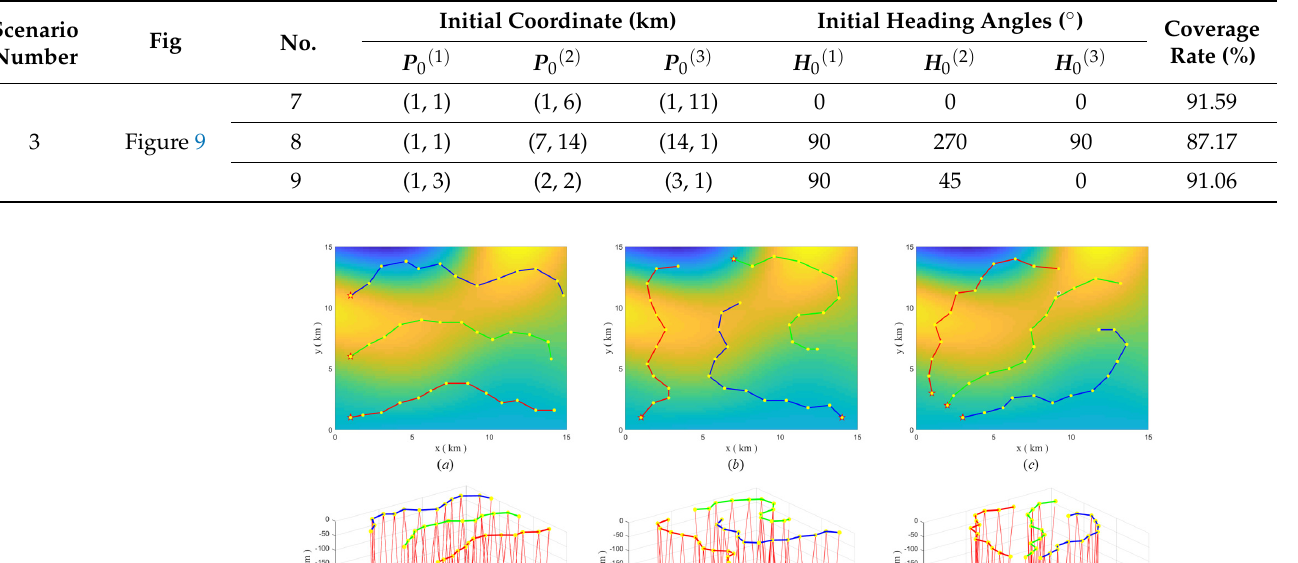
Figure 9. The MGCPP − ACO algorithm path planning results in scenario 3 (where ( a – c ) are 2D plane trajectories, and ( d – f ) are 3D space trajectories). 5.3. Performance Comparison 5.3.1. Scanline Covering (SCAN) Algorithm The scan-line (SCAN) algorithm proved to be simple and effective when covering rectangular areas [21]. The coverage path consists of straight lines and 90° turns, and the two parallel lines are separated by twice the detection radius to minimize overlapping coverage [22]. We decompose the entire area into rectangular areas equal to the number of UGs, where each glider covers an area correspondingly. They all use the SCAN algorithm to cover sub-regions. The UG uses the most energy-efficient gliding angle for sailing while avoiding hitting the seabed. Because of the different gliding parameters each time, the horizontal distance of gliding is also different. There is a different detection radius at different locations, so we use twice the average detection radius of the entire sea area as the interval between parallel lines. The UG will automatically calculate the glide period according to the inter- val. Figure 10 shows the motion trajectories of the SCAN algorithm in 2D space and 3D space, respectively.